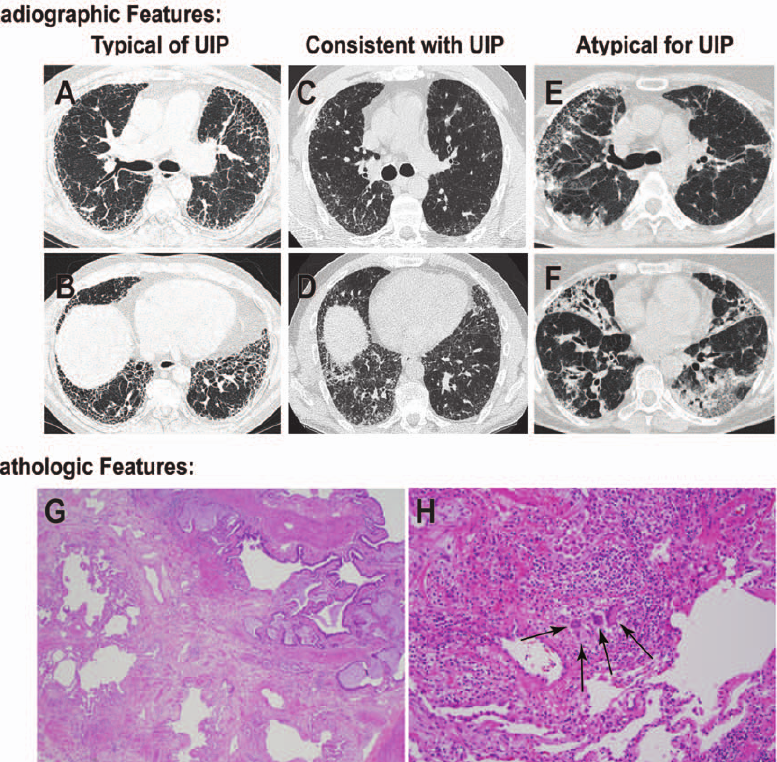
Figure 3. Radiographic and pathologic findings of heterozygous TERT mutation carriers with pulmonary fibrosis. Computed tomography (CT) scans of three different subjects with pulmonary fibrosis. Representative cases are shown with a pattern typical of Usual Interstitial Pneumonia (UIP) with peripheral, basal-predominant fibrosis and moderate to severe honeycombing ( A,B ), a pattern consistent with UIP with peripheral, basal-predominant fibrosis in the absence of honeycombing ( C,D ), and a pattern atypical for UIP with fibrosis predominantly affecting the upper lobes and along the bronchi ( E, F ). Scans are shown at the level of the carina ( A, C, E ) and the lung base ( B, D, F ). The majority (25 cases or 86%) of TERT mutation carriers with lung specimens available for review had diagnostic histologic features of UIP. In this low magnification view of UIP ( G ), typical variegated honeycomb areas (top right) are seen alternating with normal areas (left) and scarred lung (bottom). The case shown in ( H ) shows increased inflammation and a small, loosely aggregated non-necrotizing granuloma (arrows) that is characterized by a cluster of epitheloid histiocytes and multinucleated giant cells surrounded by chronic inflammation in the interstitium. Panels G and H are shown at 40 and 100-fold magnification, respectively.